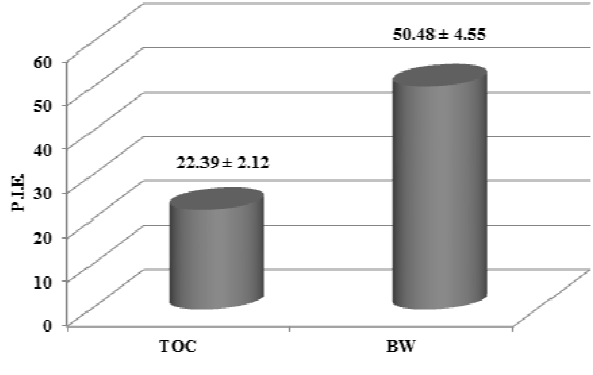
Figure 2. Percentage inhibition of erythema (PIE) values obtained after skin application of formulations containing either the blanch water extract (BW, 2%) or tocopheryl acetate (TOC, 2%), calculated vs . blank